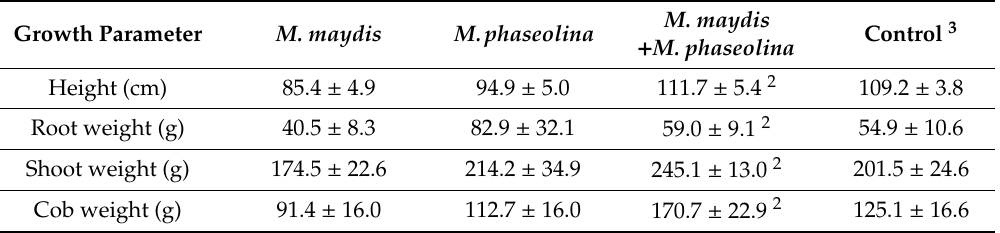
Figure 3. qPCR diagnosis of M. maydis and M. phaseolina in maize at the end of the season. The experiment is described in Figure 2. M. maydis relative DNA ( Mm ) or M. phaseolina relative DNA ( Mpk ) abundance normalized to the cytochrome c oxidase (Cox) DNA was evaluated at 82 DAS (25 days after fertilization, DAF) in roots in the 2018 experiment (upper panels) and 79 DAS (25 DAF) in shoots in the 2019 experiment (lower panels). Vertical upper bars represent the standard error of the mean of 10 replications (pots, each containing one plant). Table 5. Maize average growth indices at 82 DAS (25 DAF 1 ) as a result of infection with M. maydis and M. phaseolina (the 2018 experiment).